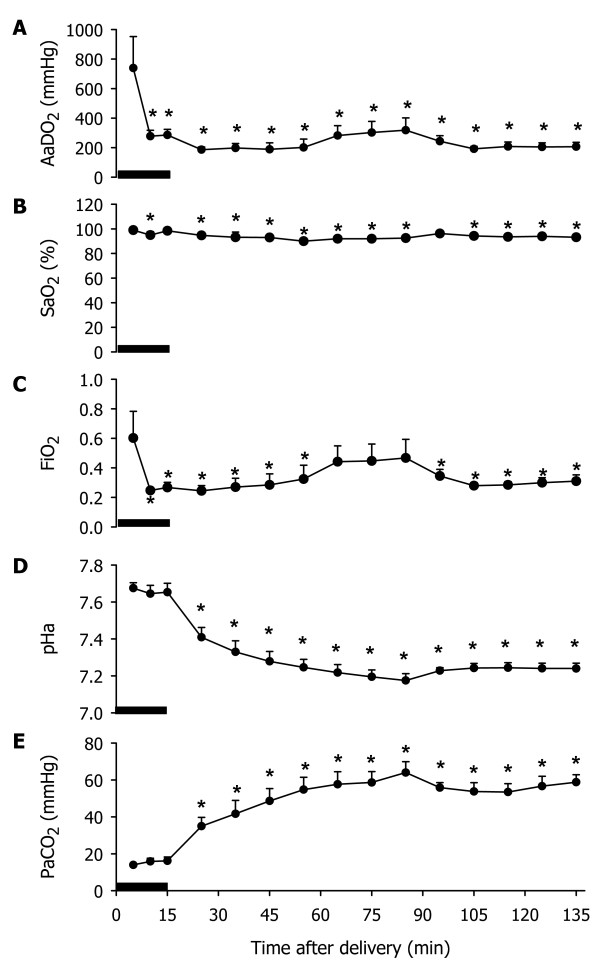
Blood gas parameters following 15 minutes of injurious ventilation. The alveolar-arterial difference in oxygenation (AaDO2) (A), oxygen saturation (SaO2) (B), fraction of inspired oxygen (FiO2) (C), arterial pH (pHa) (D) and partial pressure of CO2 in arterial blood (PaCO2) (E) in preterm lambs at 132 days of gestation resuscitated at birth using an injurious ventilation strategy then ventilated gently for 120 minutes. Values are mean ± SEM. The black bar indicates 15 min of ventilation with 20 mL/kg VT and 0 cmH2O of positive end-expiratory pressure. The asterisks (*) represent values significantly different (p < 0.05) to the initial (5 min) time point.